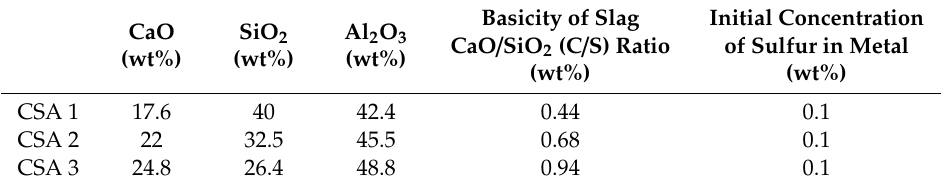
Table 1. Composition of CaO-SiO 2 -Al 2 O 3 (CSA)